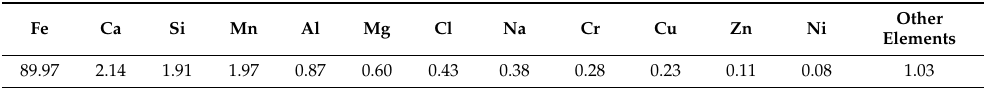
Table 2. Chemical composition of sludge mill scale,